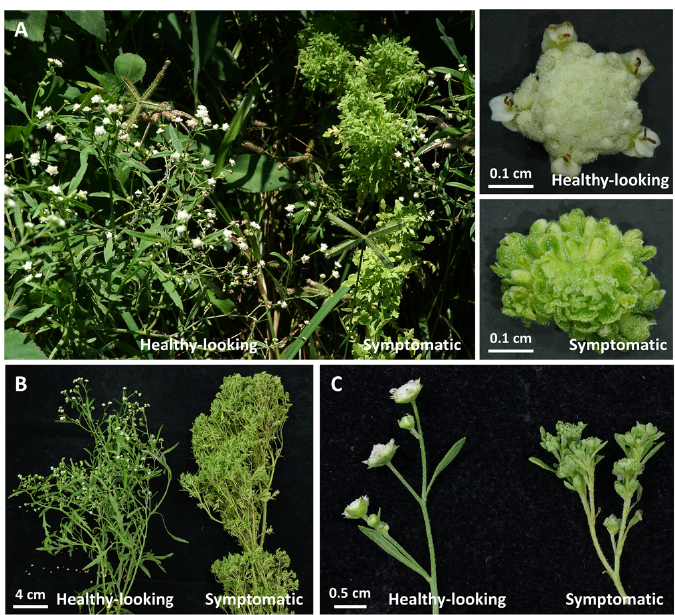
Figure 2. Disease symptoms of phytoplasma-infected parthenium weed. ( A ) Samples of healthy- looking and symptomatic plants collected in Mailiao, Yunlin, Taiwan. ( B ) Photos of a healthy-looking plant with standard branch and a symptomatic plant with dramatic branch proliferation. ( C ) Close-up view of regular flowers with yellow color and symptomatic flowers with phyllody and virescence symptoms. Enlarged images of a healthy-looking and symptomatic flower are present in the upper-right corner. 2.2. Identification of the Phytoplasma Associated with the Symptomatic Green Pea and Parthenium Weed